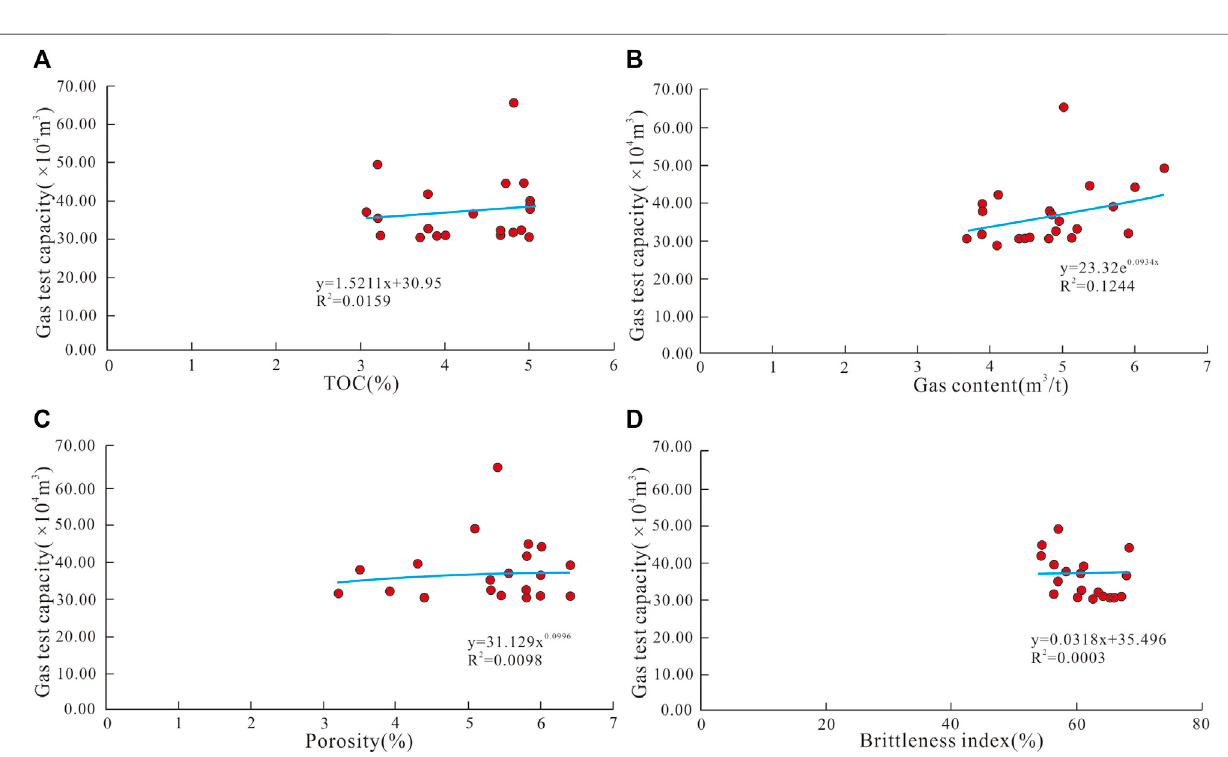
Frontiers in Earth Science |